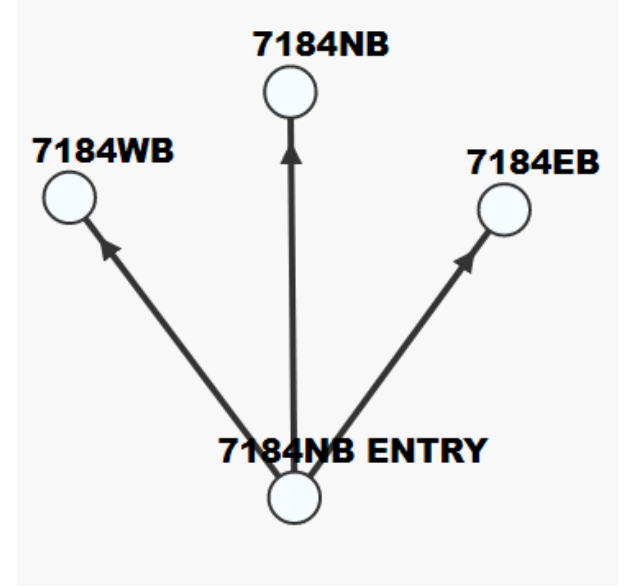
Figure 3. Network for Northbound Traffic.